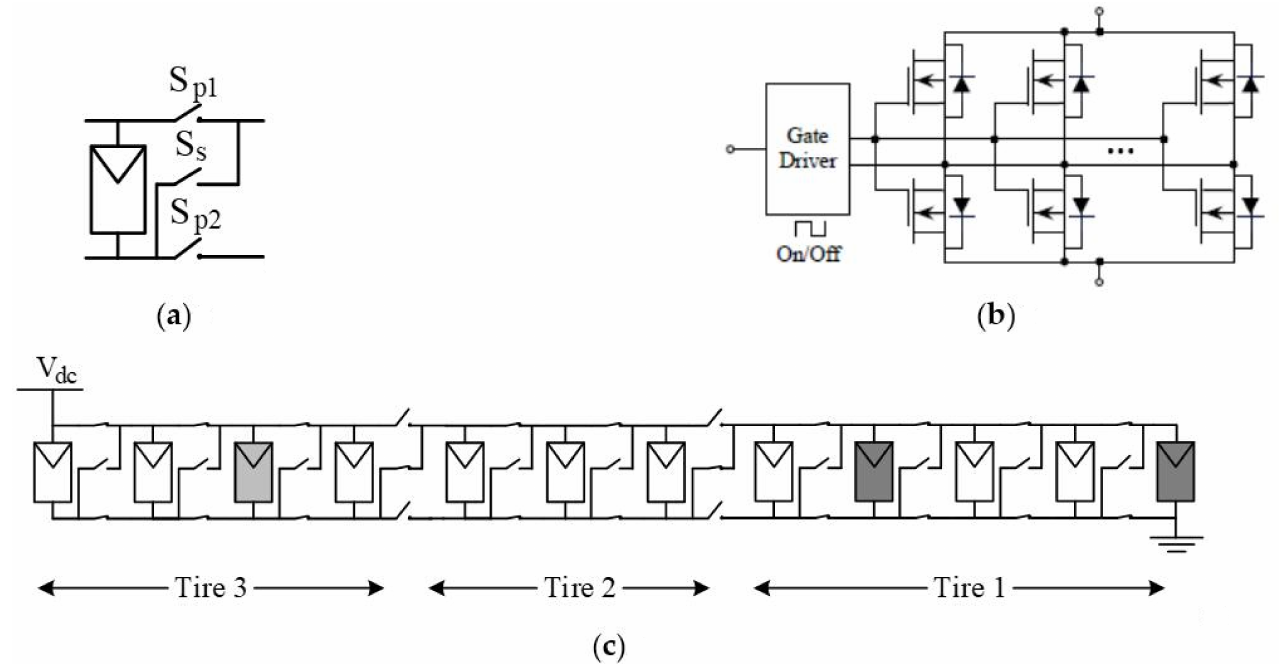
Figure 28. The reconfigurable PV panel: the Dynamic Macro Cell assembly ( a ); the bidirectional switch circuitry ( b ); an example of reconfiguration of 12 cells into a three-level TCT array ( c )